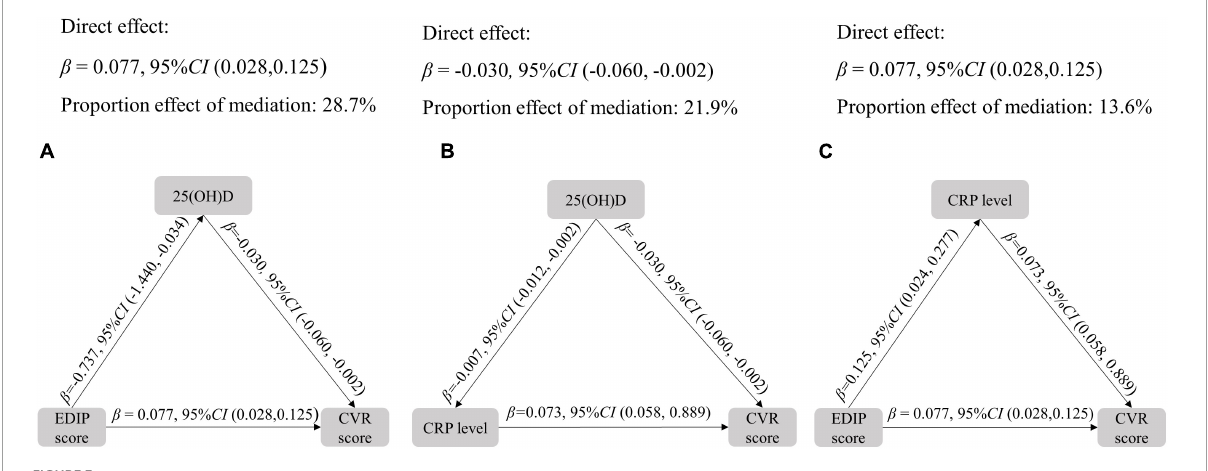
FIGURE3 Mediation analysis among EDIP score, CVR score, and hs-CRP. All models adjusted for age, residence, education, income, pre-pregnancy BMI, parity, gestational weight gain, family history of diabetes and hypertension, physical activity, outdoor time, sedentary time, and vitamin D supplementation frequency. CVR, cardiovascular risk, EDIP, Empirical dietary inflammation